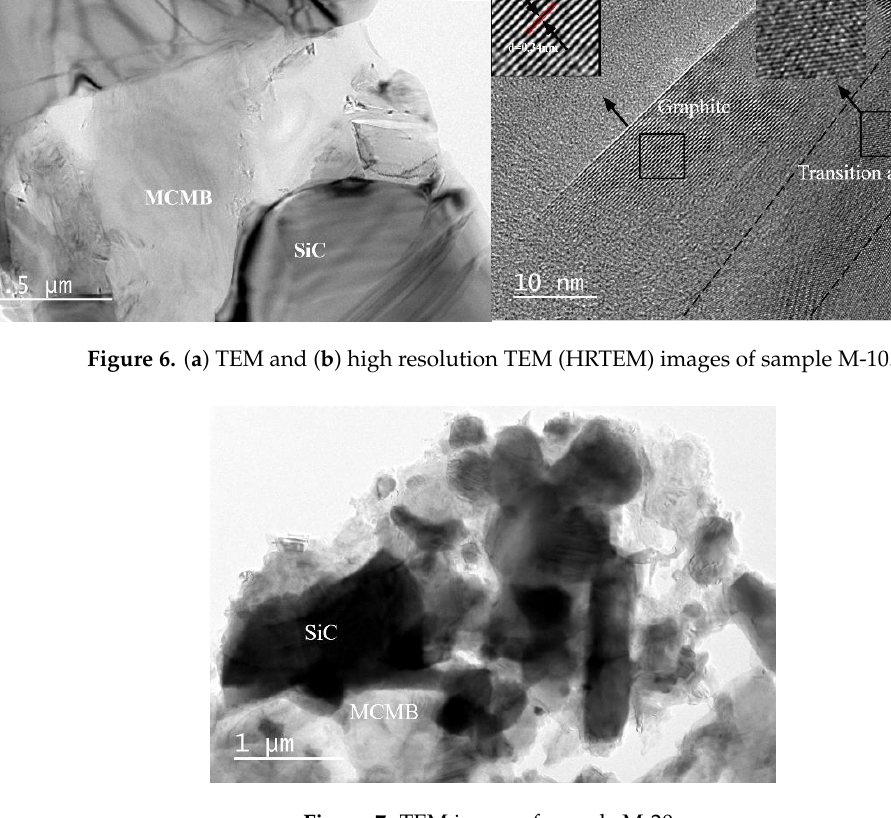
Figure 7. TEM image of sample M-20.